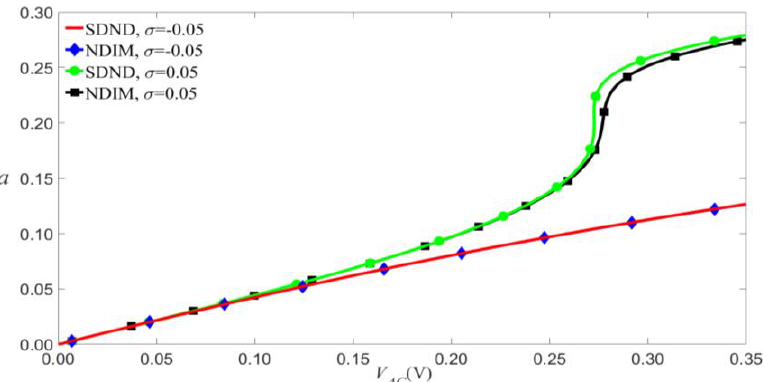
Figure 10. Amplitude of the response as a function of the load’s amplitude of primary resonance for V DC = 4 V, P 0 = 0.01 N, and c 2 = 0.03.